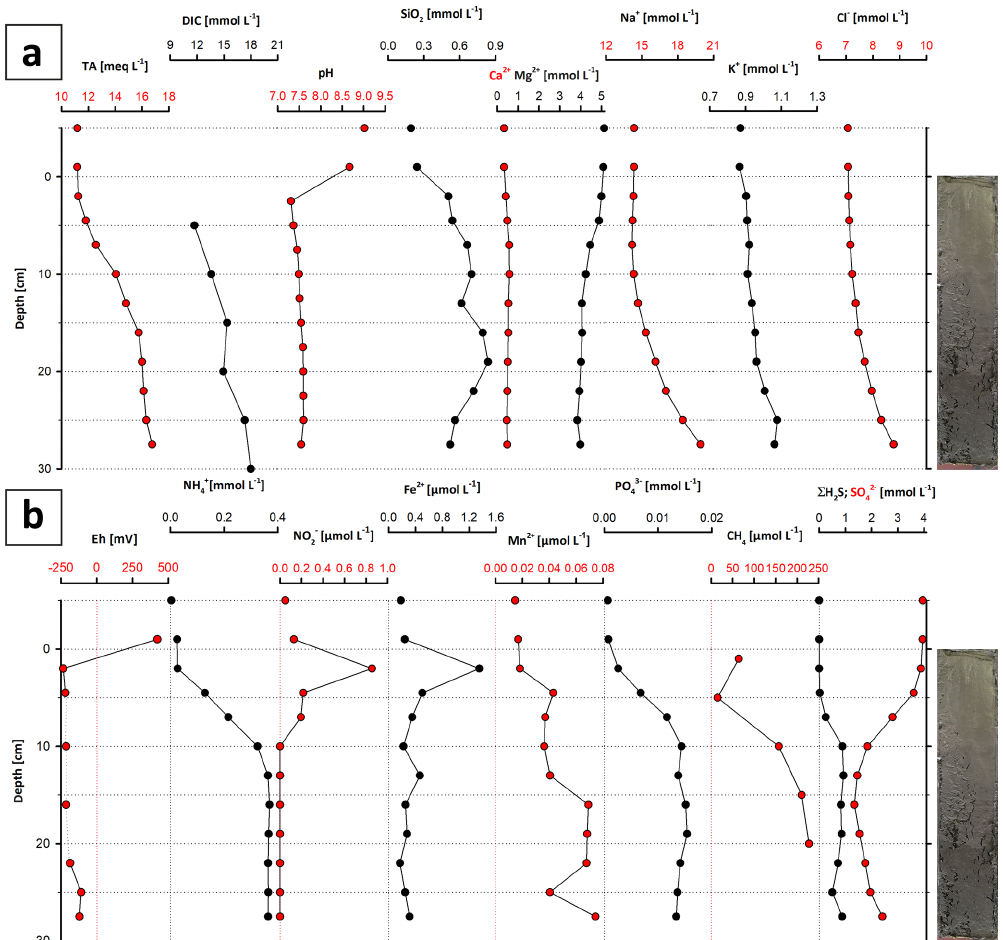
Figure 9. Major ion (a) and metabolite concentrations (b) in the pore water of core LN-K03. Note that the sample slightly above 0cm depth represents the supernatant water, and the top data points represent the water column (see text for